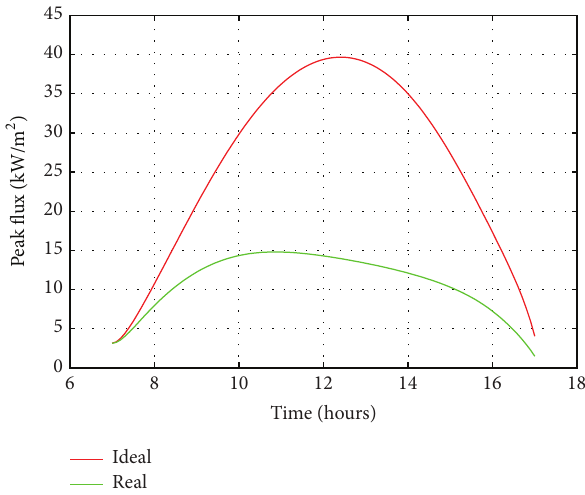
Figure 9: Peak flux comparison for the 5 heliostats of Figure 8, with no drift (ideal) and with drift (real), for the summer